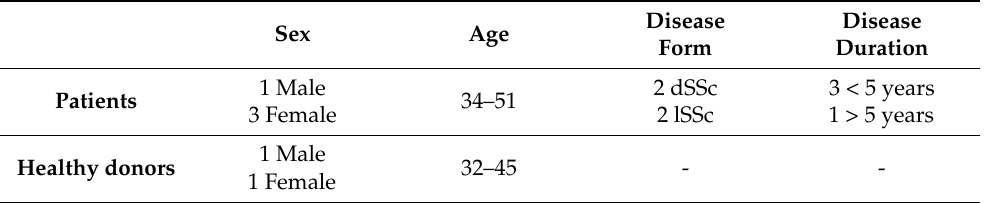
Table 1. Clinical characteristics of SSc patients and healthy